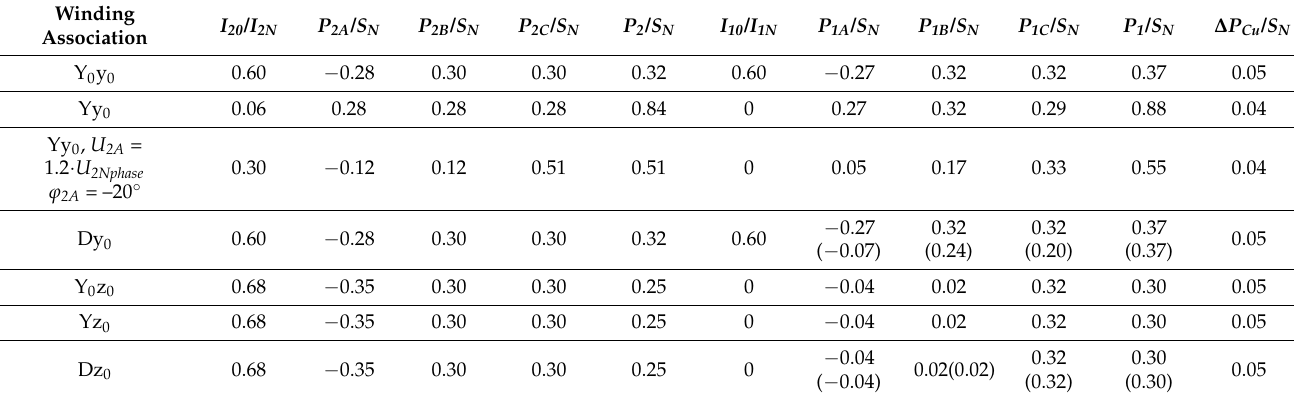
Table 1. Calculation results for MV/LV transformer. In brackets, the results of phase active power calculations for the delta connection that are exchanged with the grid—without the zero component of phase